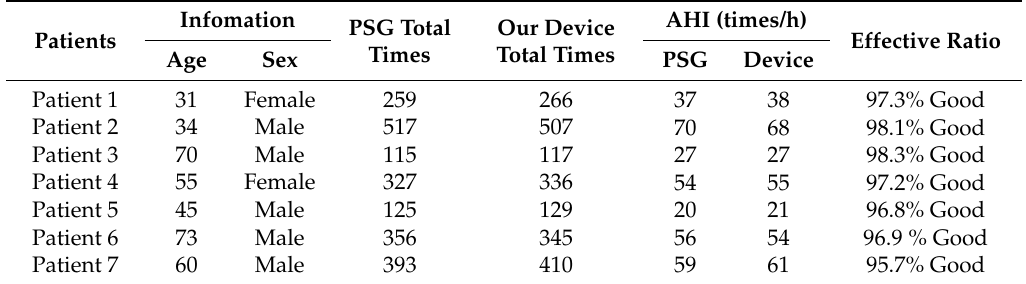
Table 1. Apnea-hypopnea events extracted by PSG and the proposed